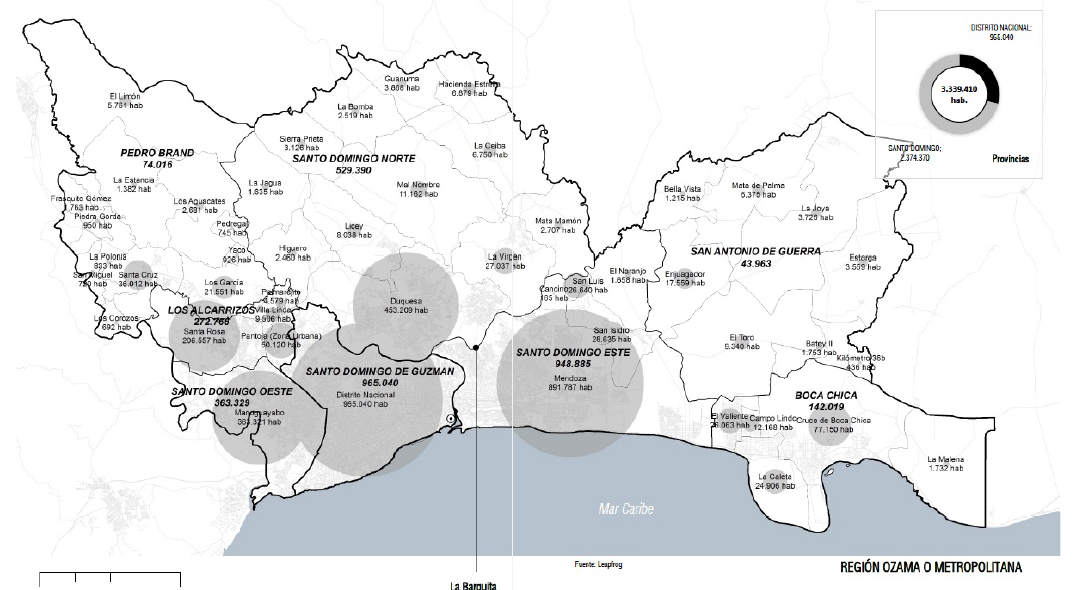
Figure 2. La Vieja Barquita in the greater Santo Domingo, and its areas’ populations. Source: Unit for the Transformation of La Barquita and its Surroundings (URBE,